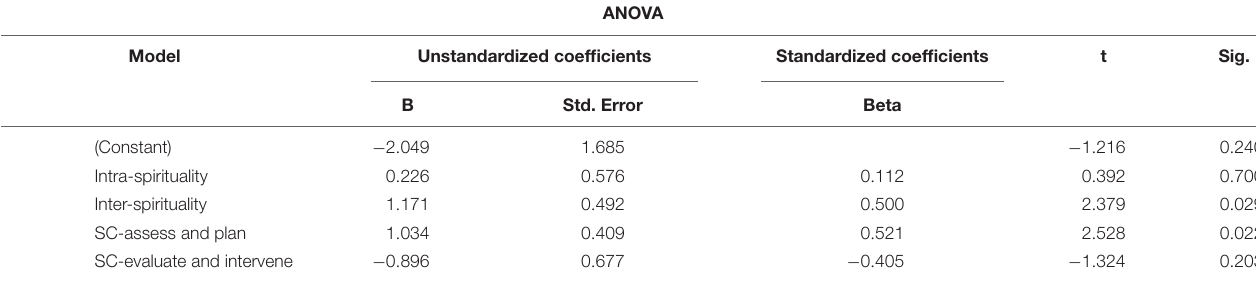
TABLE 2 | Importance of spiritual